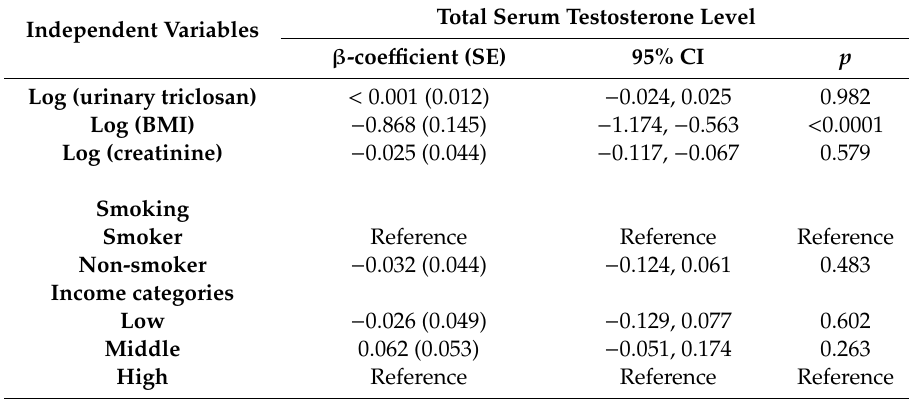
Table 3. Regression analysis for urinary triclosan and total serum testosterone levels, adjusted for significant